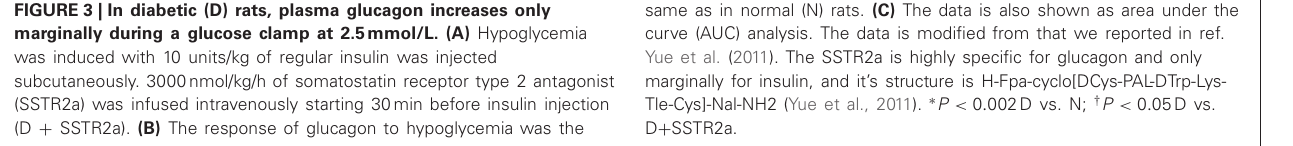
FIGURE 3 | In diabetic (D) rats, plasma glucagon increases only marginally during a glucose clamp at 2.5mmol/L. (A) Hypoglycemia was induced with 10 units/kg of regular insulin was injected subcutaneously. 3000nmol/kg/h of somatostatin receptor type 2 antagonist (SSTR2a) was infused intravenously starting 30min before insulin injection (D + SSTR2a). (B) The response of glucagon to hypoglycemia was the